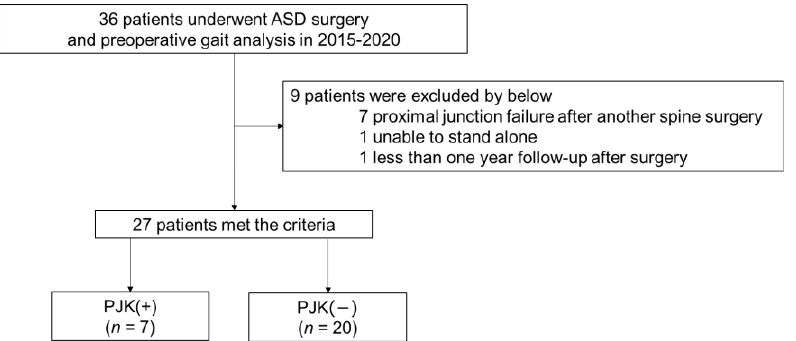
Figure 3. Patient inclusion flow chart. PJK (+) is the patient group with a proximal junctional angle (PJA) >10° soon after surgery and >10° progression of the PJA. PJK ( − ) is the patient group with a proximal junctional angle (PJA) <10° soon after surgery or <10° progression of the PJA. The cohort included seven male and 20 female patients. PJK occurred in seven (26%; Table 2. Patient one male and six females) of them. There were no significant differences in age, height,